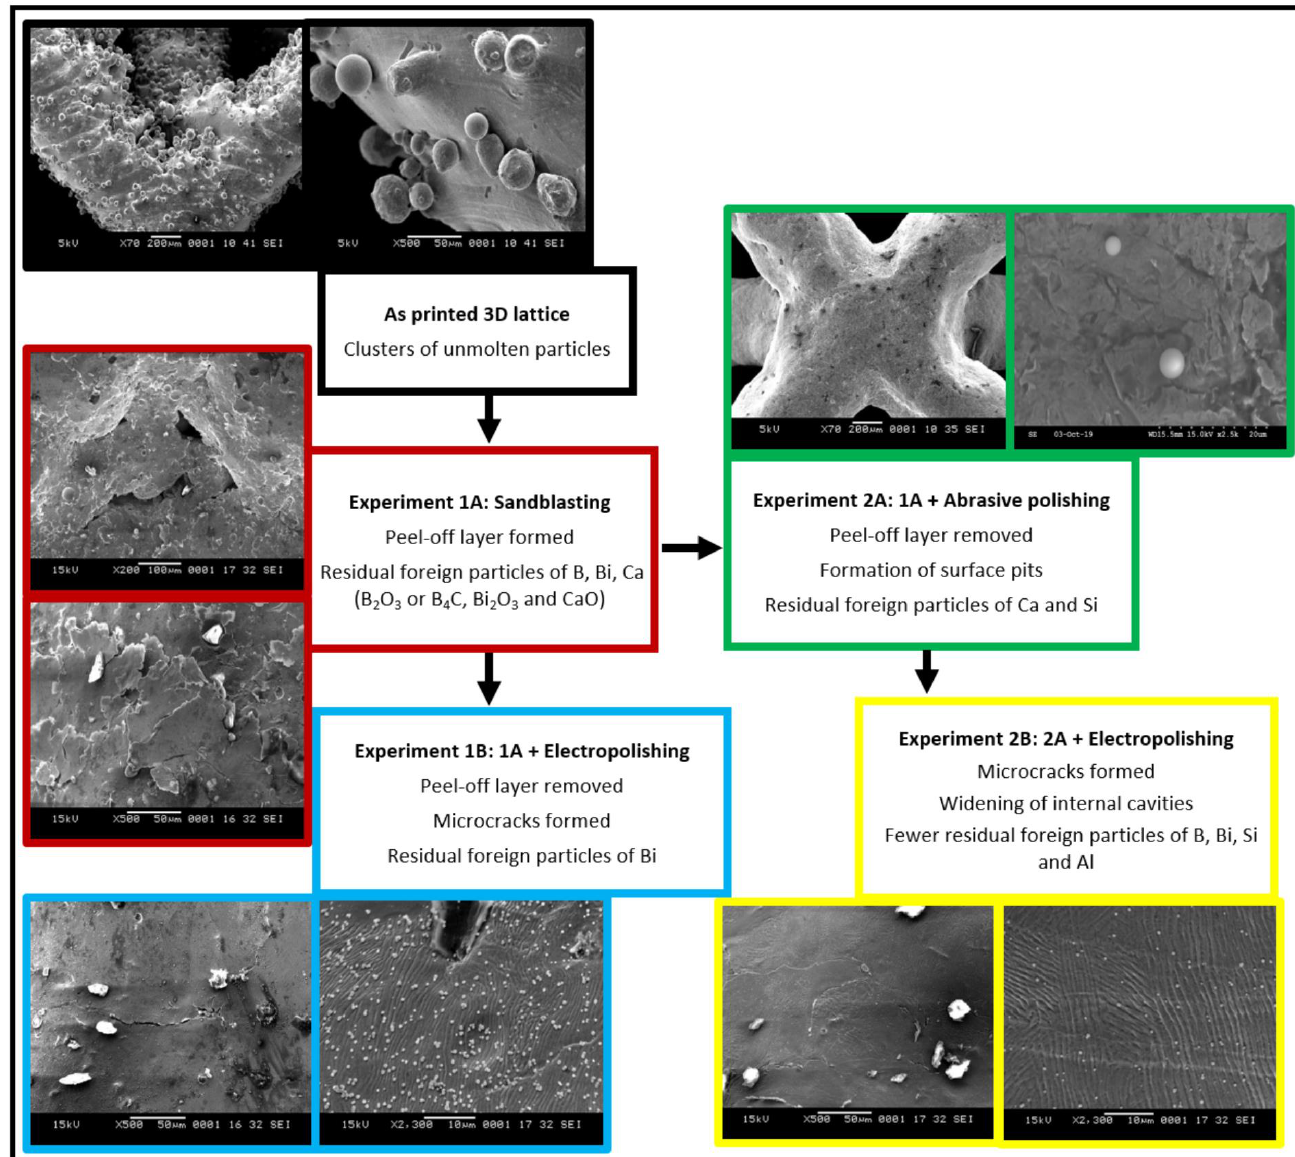
Figure 22. Summary of the effects of post processing treatments on the surface features and foreign particle distribu- tions.